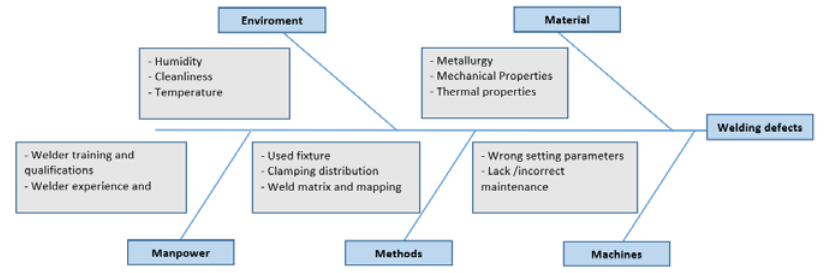
Figure 1. Ishikawa’s diagram of welding